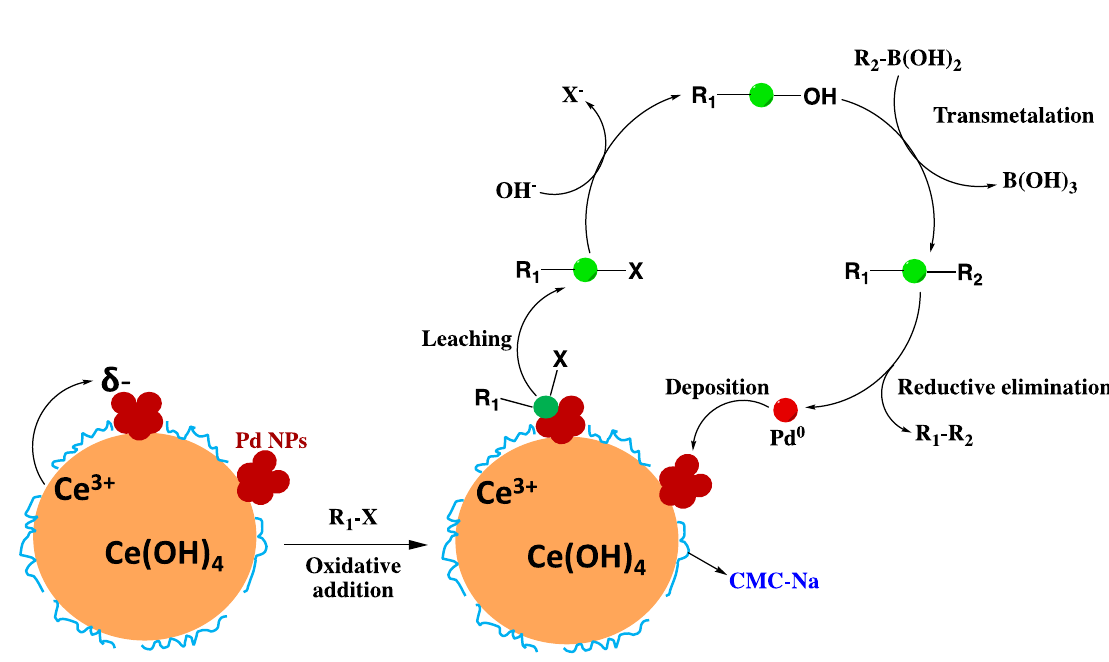
Scheme 9. Illustrative diagram of the conceptual mechanism of the Suzuki reaction catalyzed by Pd/CMC@Ce(OH) 4 [91] (Adapted with permission from Elsevier).